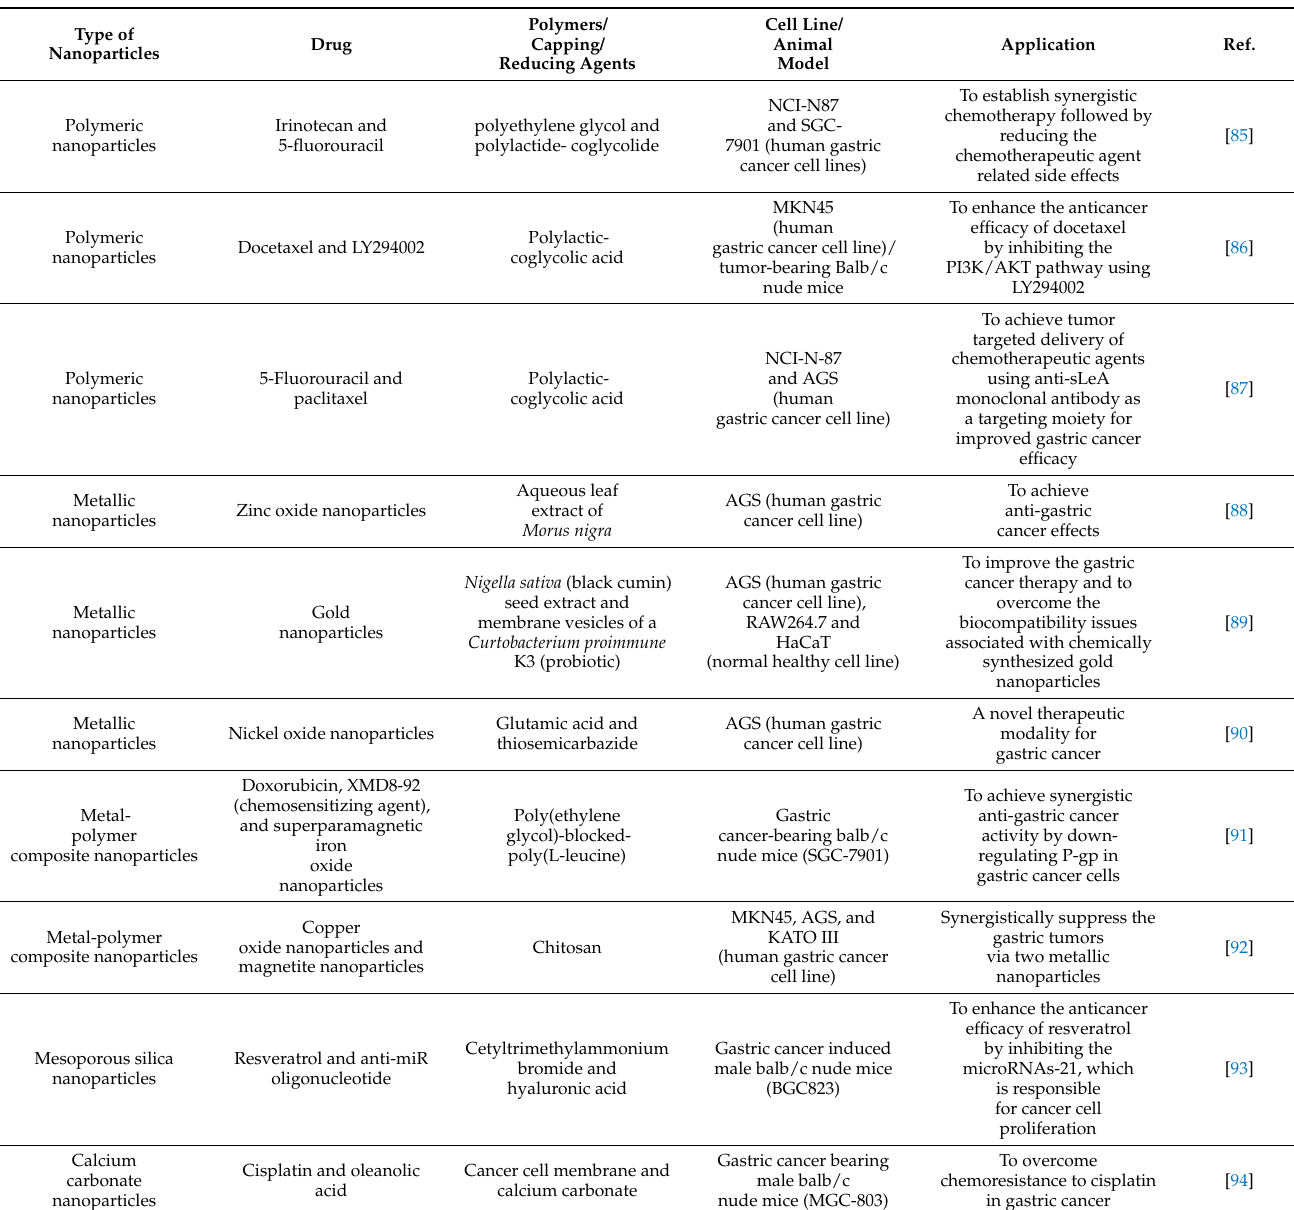
Table 1. List of nanoparticle type, anticancer drugs, polymers used, cell lines used, and application of different nanoparticles for the treatment of stomach cancer as novel drug delivery